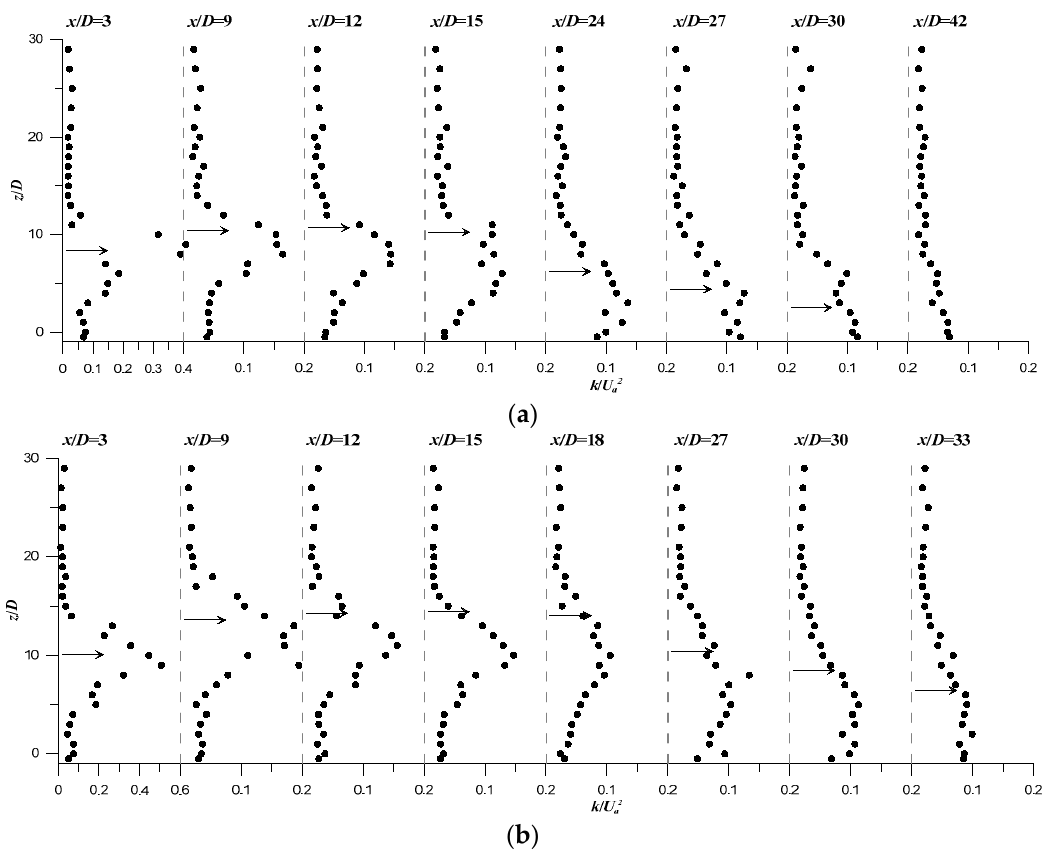
Figure 11. Vertical profiles of the normalized time-averaged turbulent kinetic energy at different downstream positions x / D : ( a ) run R1; ( b ) run R2. The horizontal arrows on the profiles indicate the position of the jet axis.